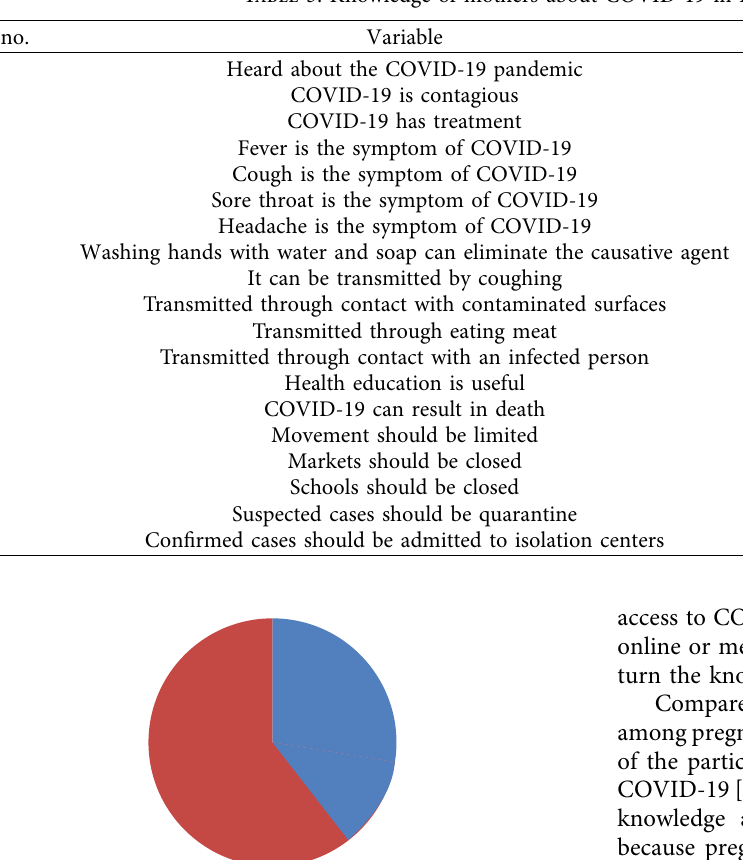
Table 3: Knowledge of mothers about COVID-19 in Dessie, Ethiopia, 2020.